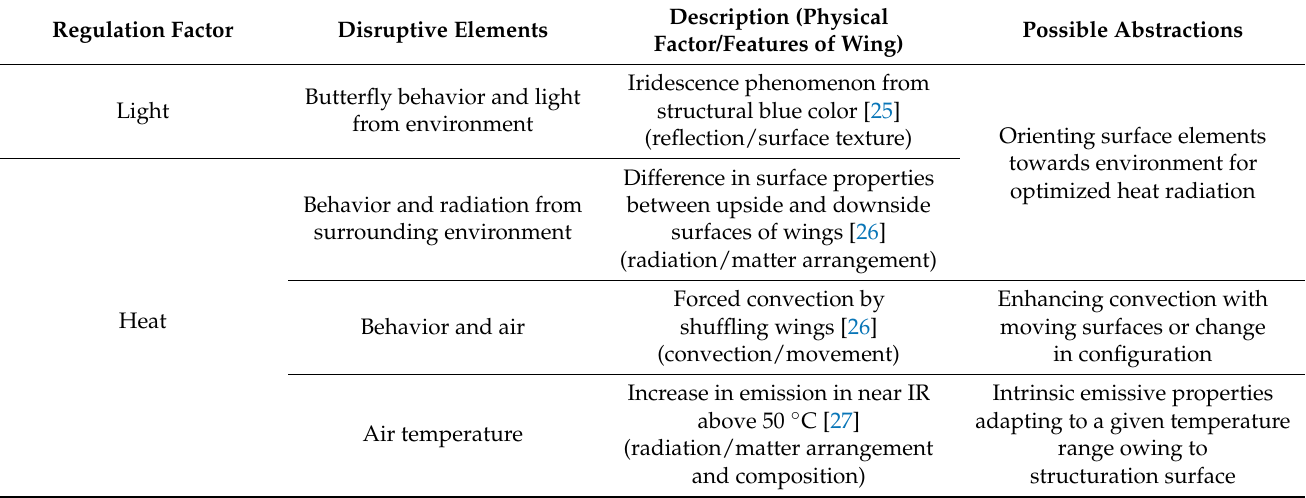
Table 1. Biotics and abiotic disruptive actions on light, heat, and air regulation functions of the Morpho